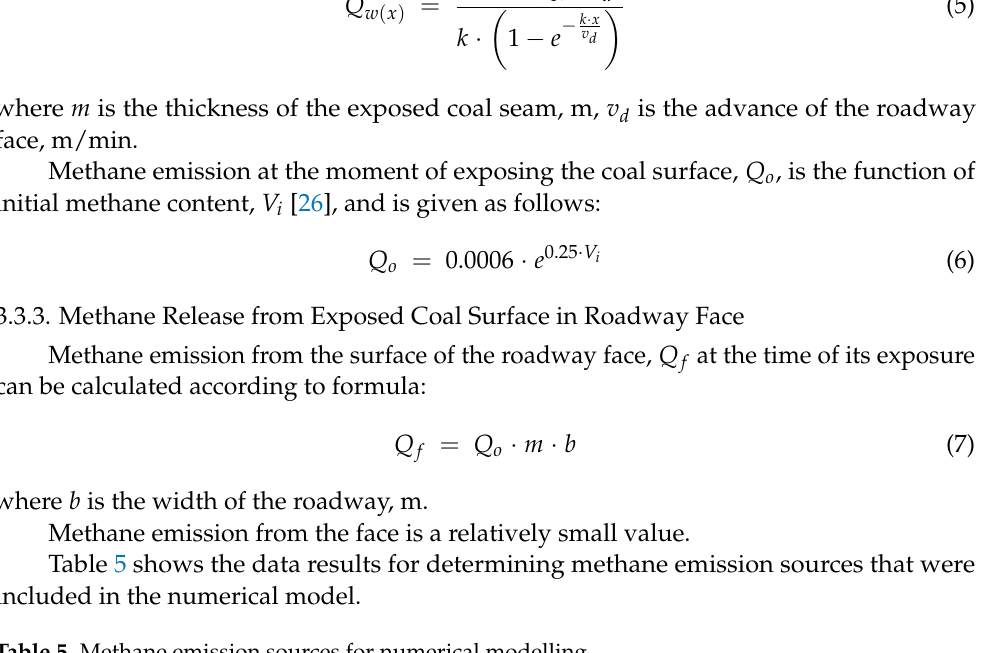
Table 5. Methane emission sources for numerical modelling. Parameter Value